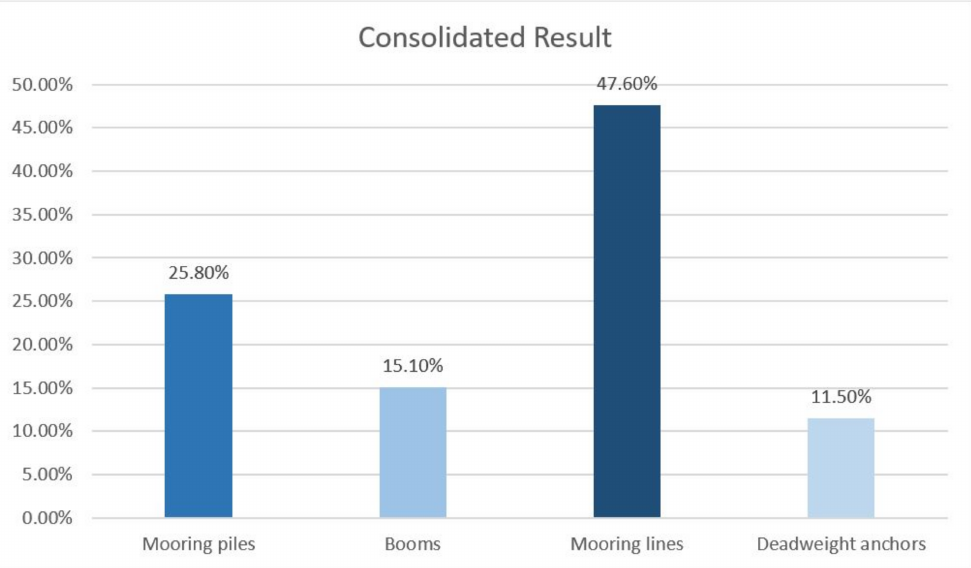
Figure 4. Indication of the most advantageous mooring system for an Investor using AHP-OS software